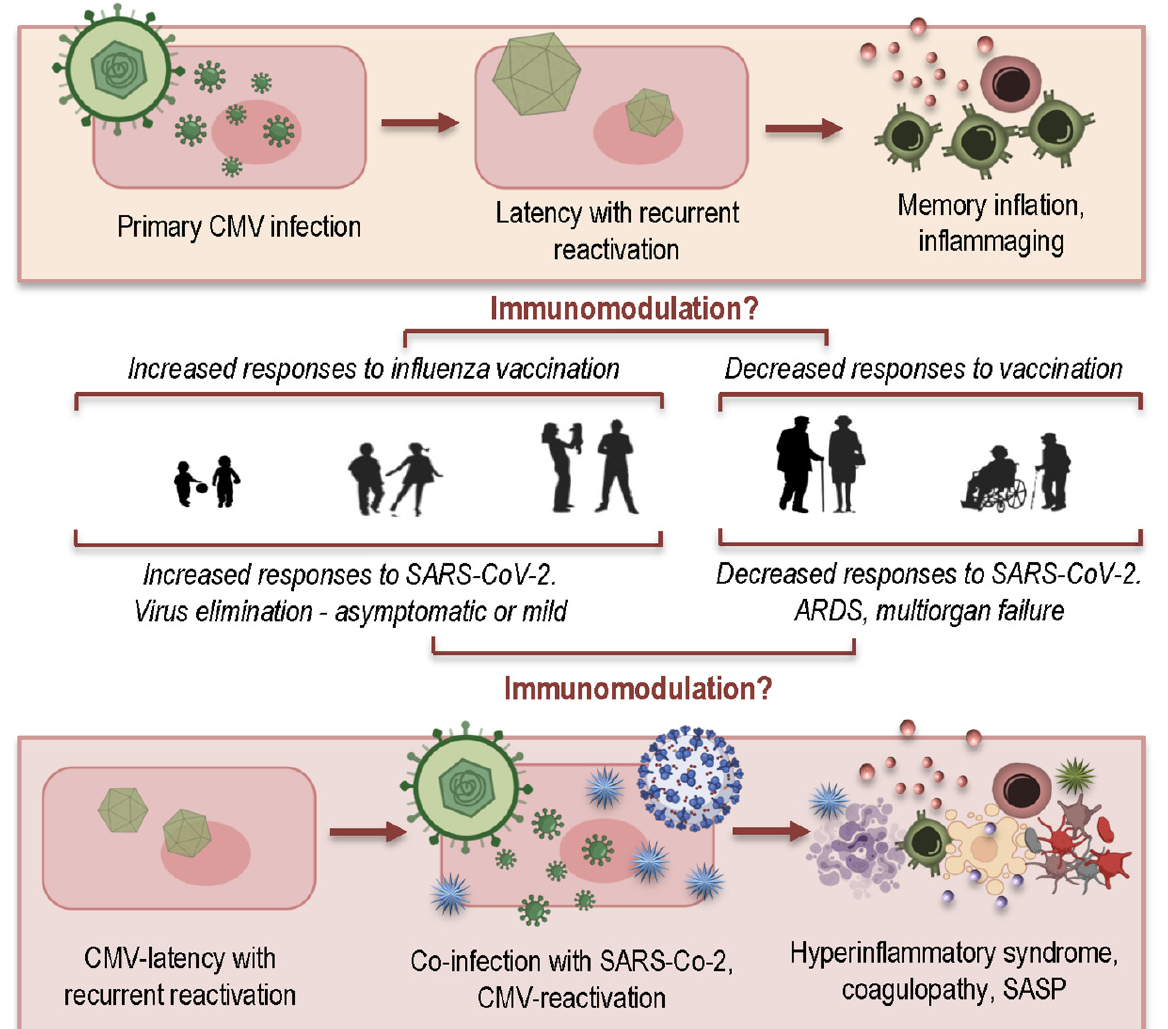
Figure 5. The age-related modulatory effect of a latent CMV infection in response to influenza vaccination, and the hypothetical age-related influences of CMV on the impact of SARS-CoV-2 infections. SASP: senescence-associated secretory phenotype; ARDS: acute respiratory distress syndrome.